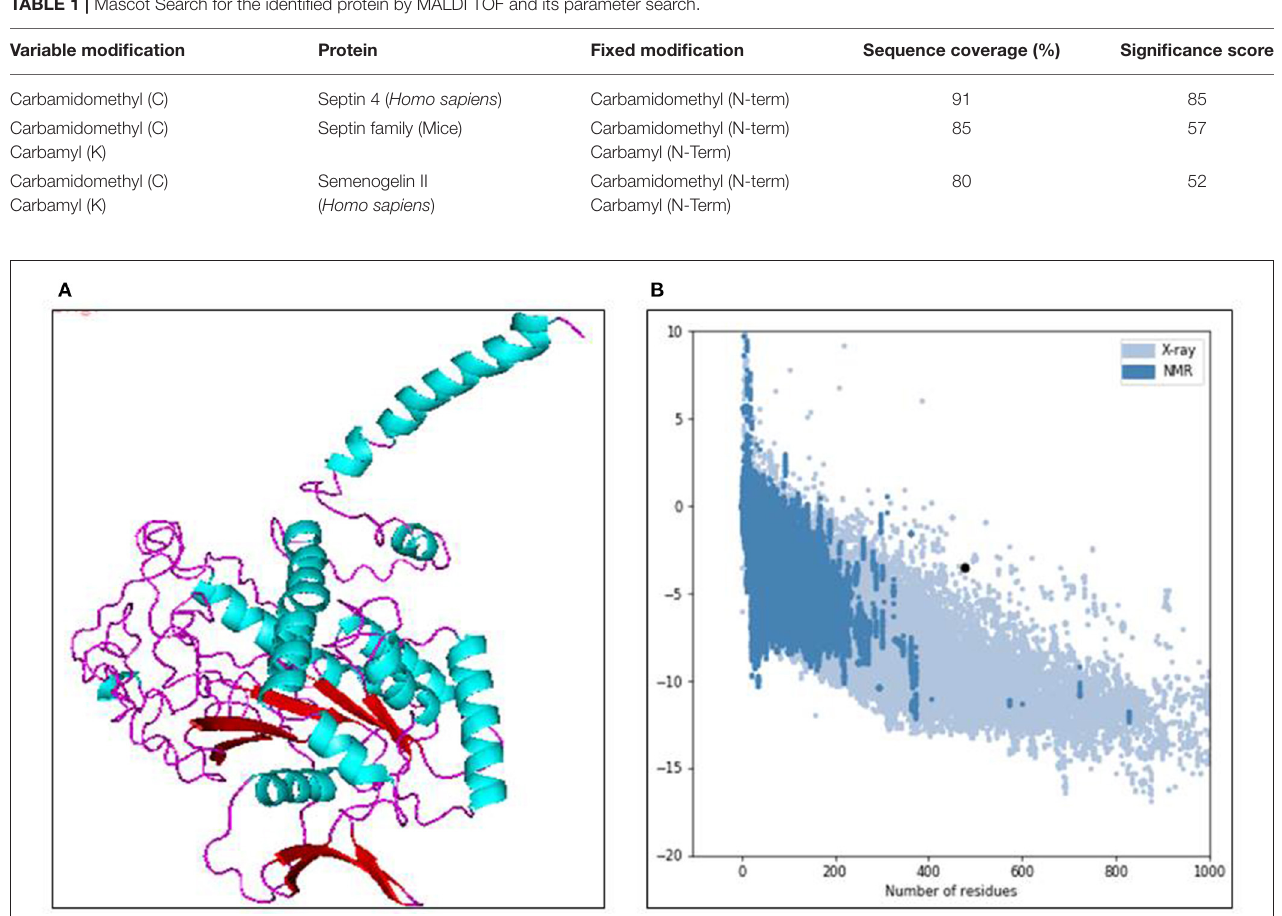
TABLE 1 | Mascot Search for the identified protein by MALDI TOF and its parameter search.